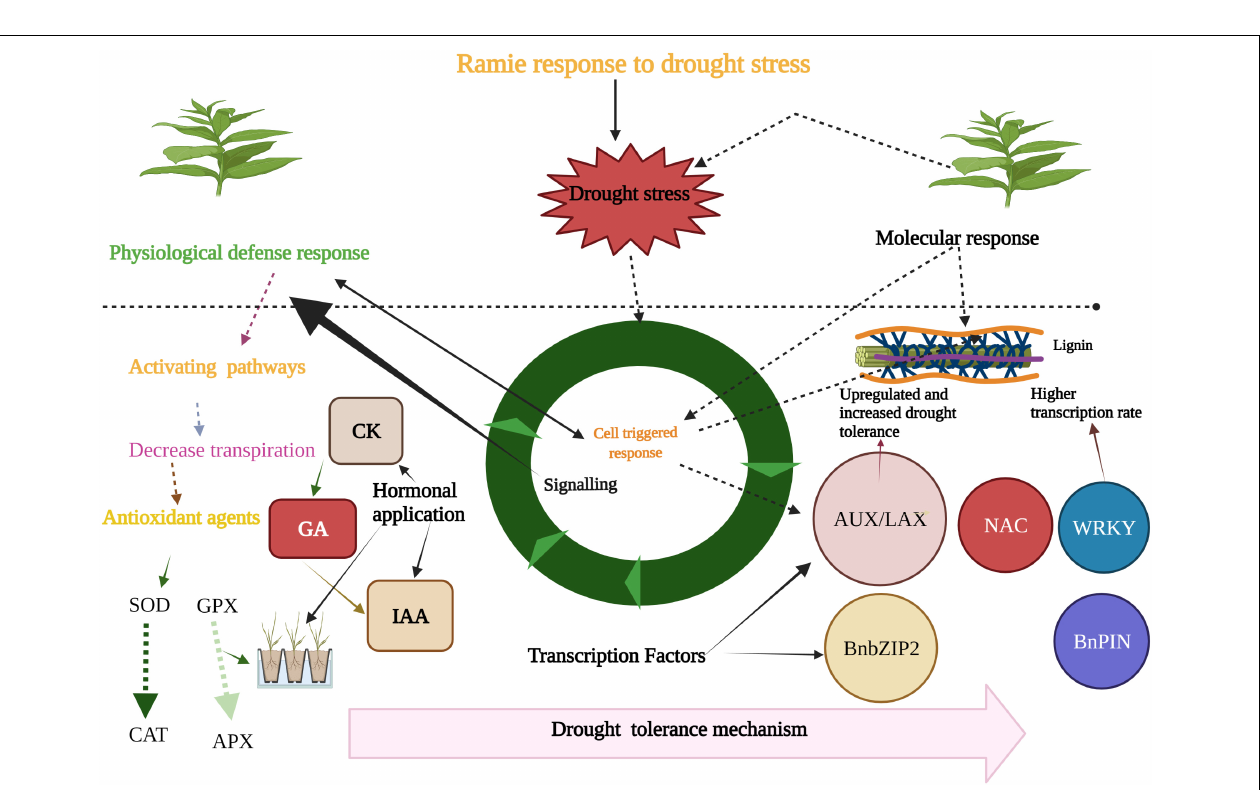
FIGURE 4 | Role of different factors to enhance drought tolerance in ramie. Ramie response to drought stress (DS) by various ways like, activation of different genes which provide resistance to stress. Different antioxidants like SOD, GPX, APX, and CAT are used to counter the adverse effects of DS. Hormones like, GA, CK, and IAA are being used for mitigating the effects of